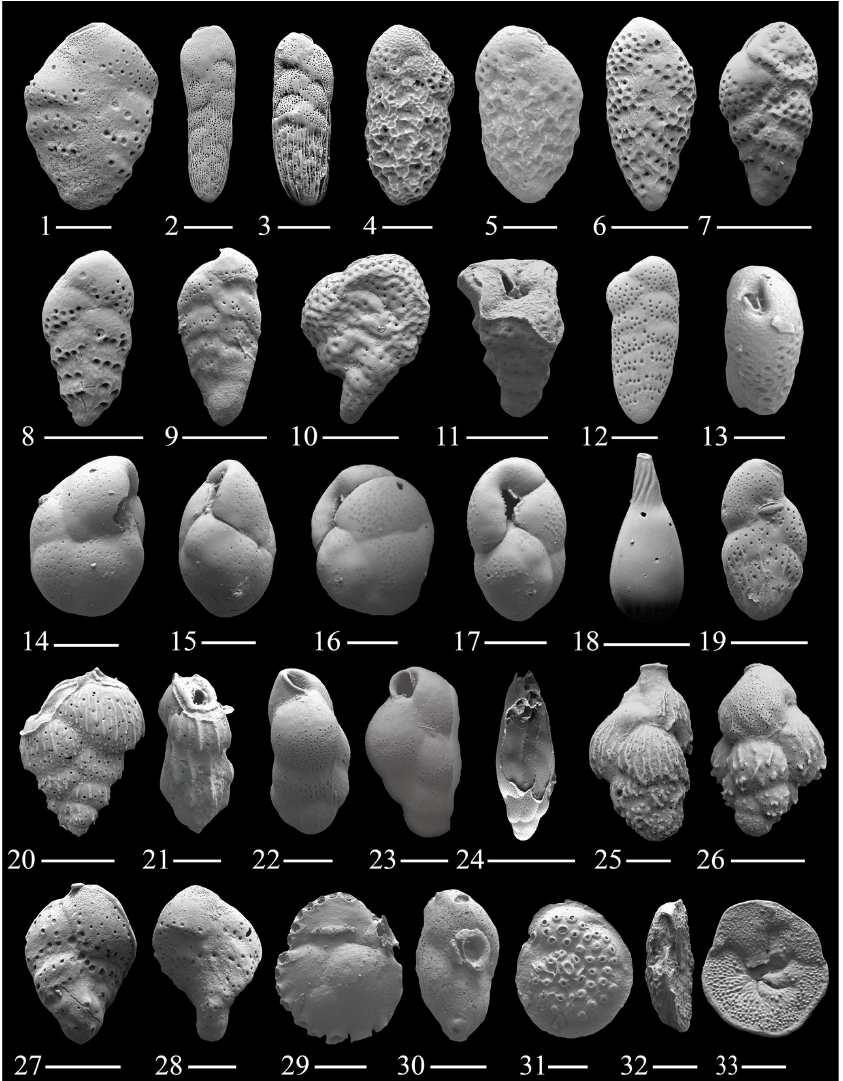
Figure 6. (1) Bolivina ordinaria Phleger and Parker; (2–3) Bolivina striatula Cushman; (4–5) Bolivina variabilis Williamson; (6–8) Bolivina cf. B. variabilis (Williamson); (9) Bolivina sp. 1; (10–11) Abditodentrix rhomboidalis (Millett); (12–13) Bolivina brevior Cushman;